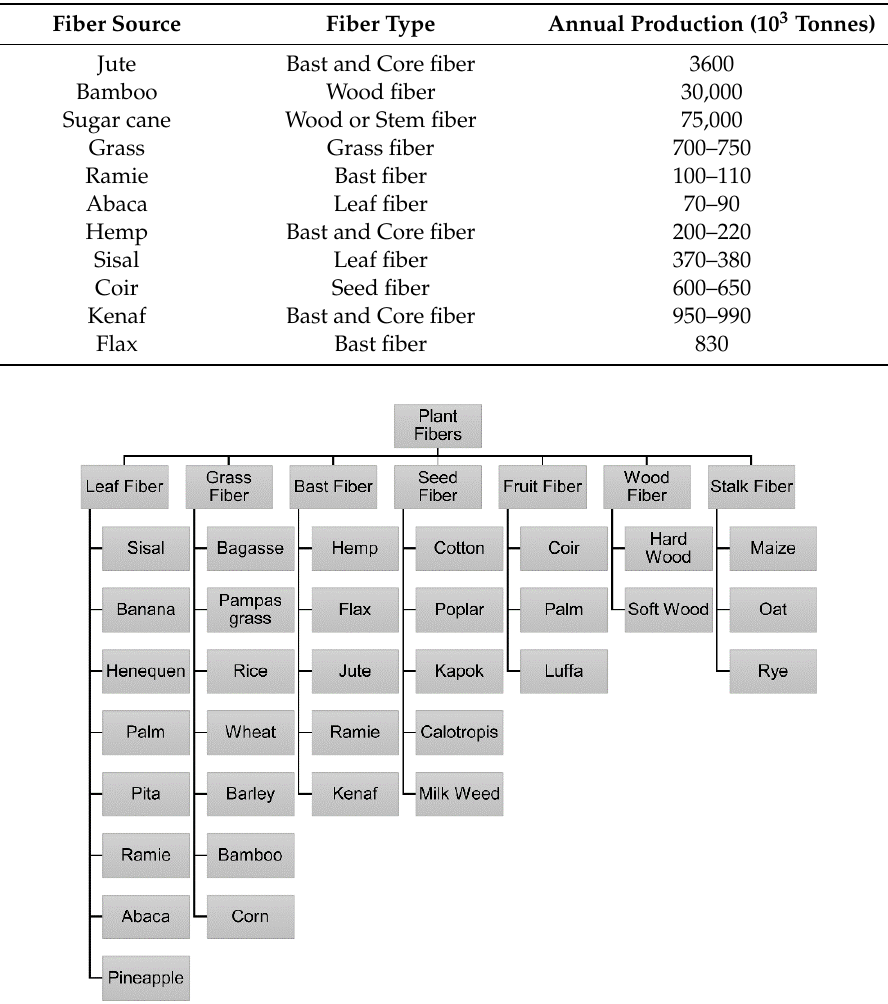
ff erent types of plant Figure 1. Different types of plant fibers. Figure 1. Di